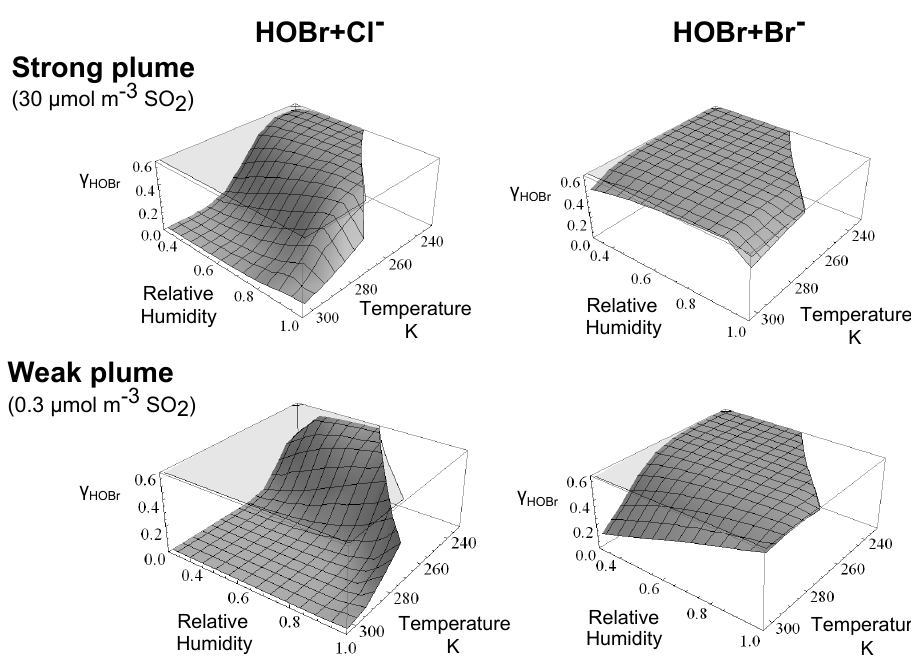
Figure 4. HOBr + Cl − and HOBr + Br − reactive uptake coefficients onto volcanic sulfate aerosol particles of 1µm radius, calculated us- ing our revised HOBr kinetics. Calculations are performed for a typical Arc or subduction zone volcanic plume composition containing a (SO 2 ) :HCl:H 2 SO 4 :HBr molar ratio mixture of 1:0.5:0.01:0.00075. The plume strength is 30, or 0.3µmolm − 3 , equivalent to approx- imately 1 or 0.01ppmv SO 2 at 4km altitude (US standard atmosphere). Conversely, uptake coefficients calculated using the termolecular approach yield high accommodation-limited values across all parameter space (light